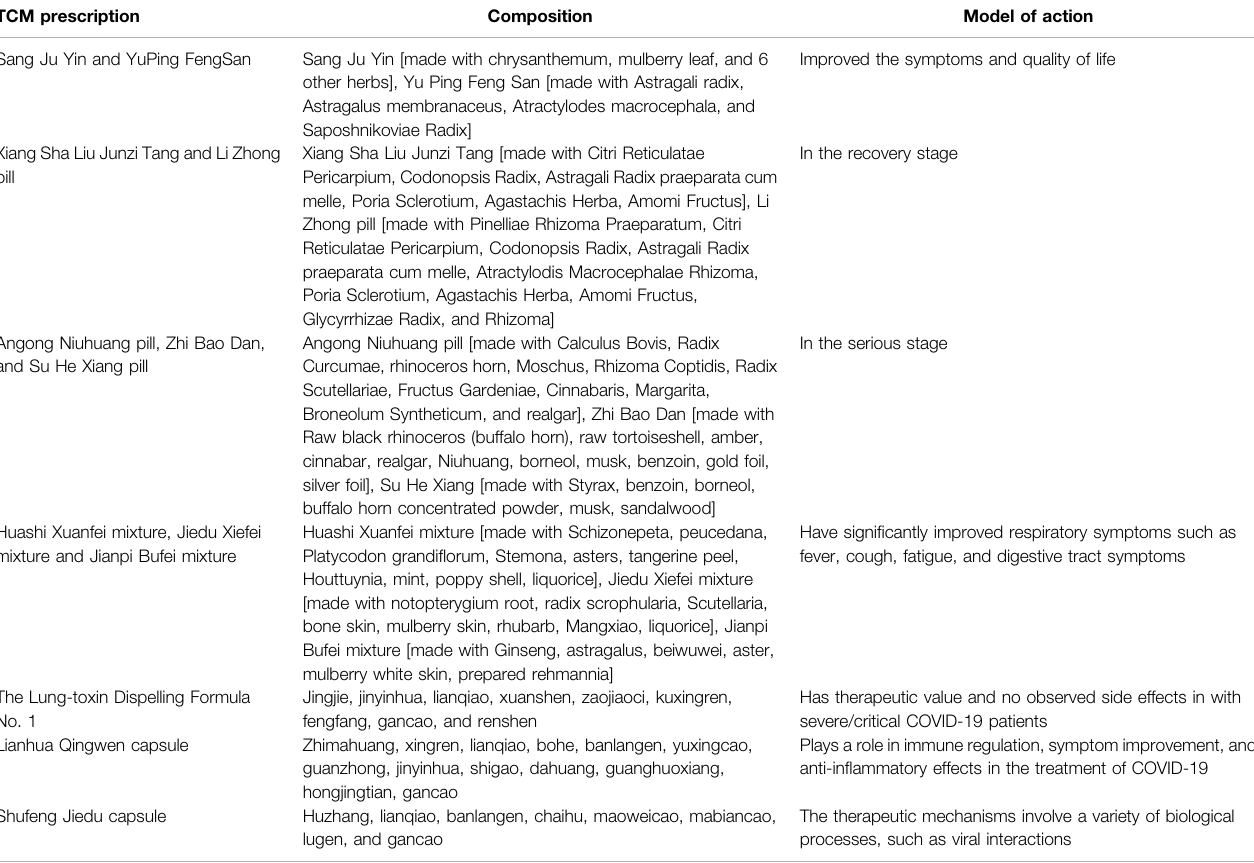
TABLE 2 | TCM prescription for treating patients with